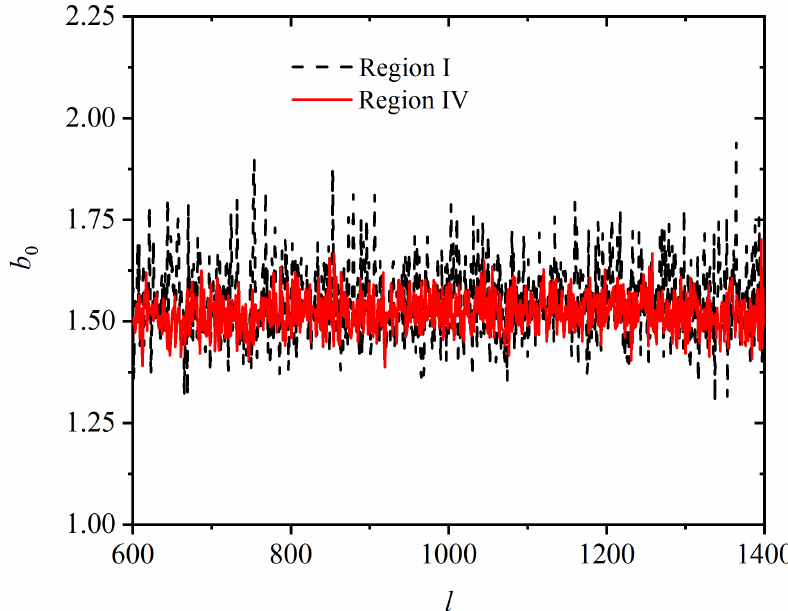
Figure A2. Plot of Kuhn length b 0 as a function of chain length averaged over Regions I and IV. Within statistical uncertainty, the Kuhn length b 0 = 1.52 ± 0.05 is independent of the chain length l ∈ [ l min , l max ] , and is the same for both